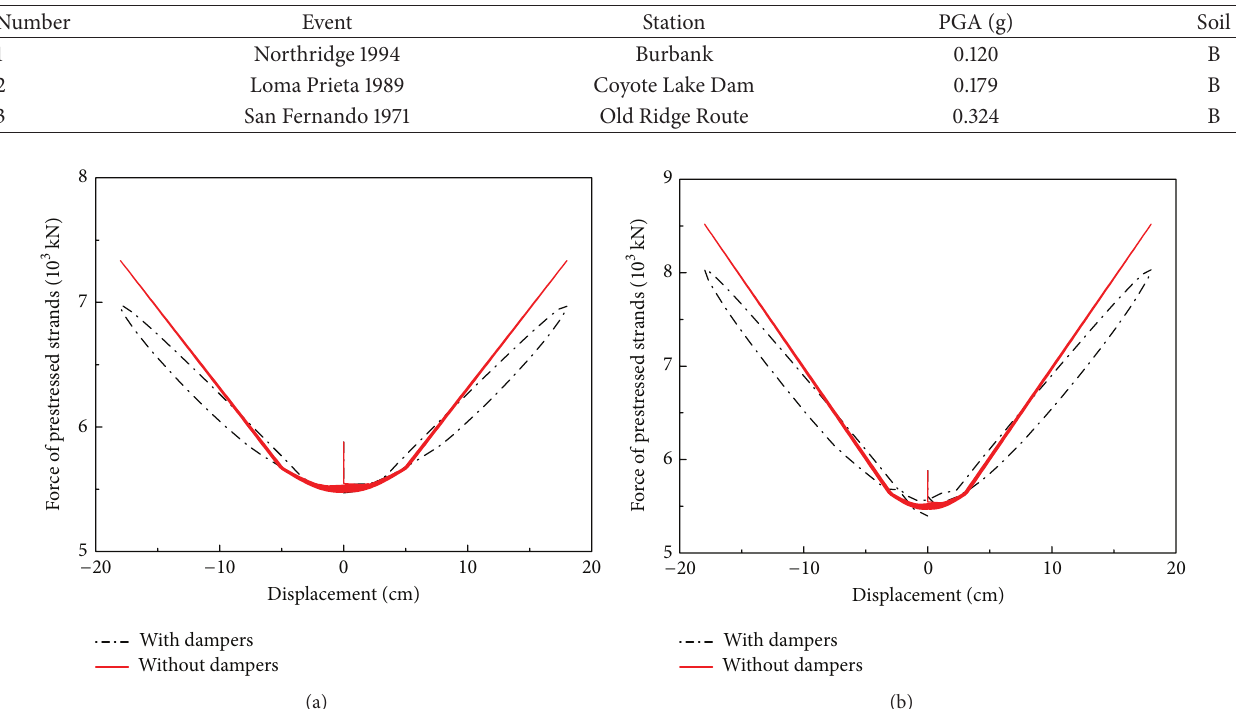
Table 2: Earthquake records used for the time history analysis.